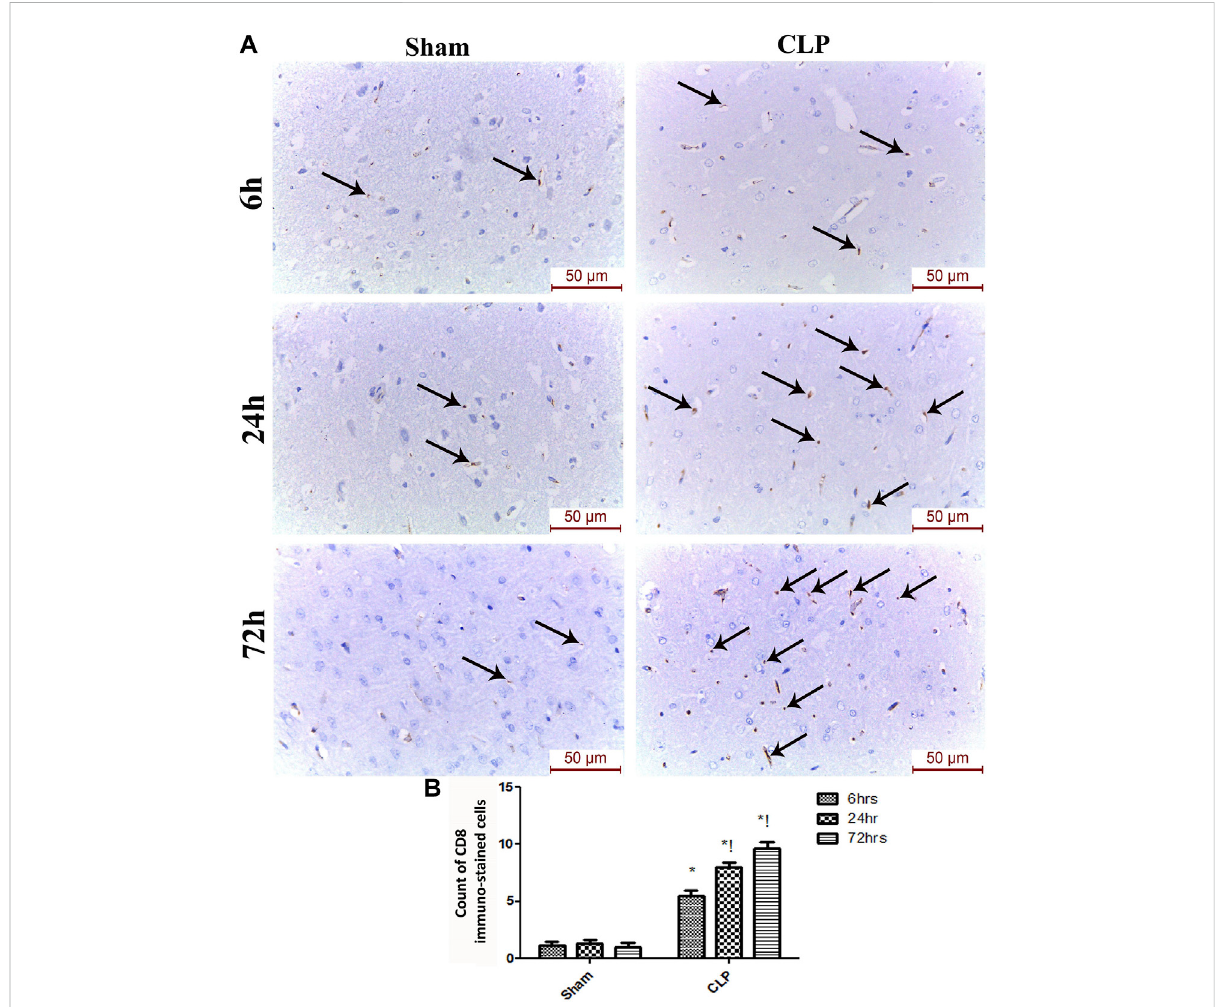
FIGURE 4 Sepsis enhanced the in fi ltration ofCD 8macrophages in brain tissues. (A) Immunohistochemical evaluation of CD8 expressioninthe shamand cecal puncture and ligation (CLP) groups at different time points. (B) Count of cells that were immunohistochemically stained for CD8. Data are presented as the mean ± S.E.M. ( n = 6).*: Statistically signi fi cant vs. Sham; !: signi fi cant vs. 6 h CLP; #: signi fi cant vs. 24 h CLP; as assessed using ANOVA with the Bonferroni post-hoc